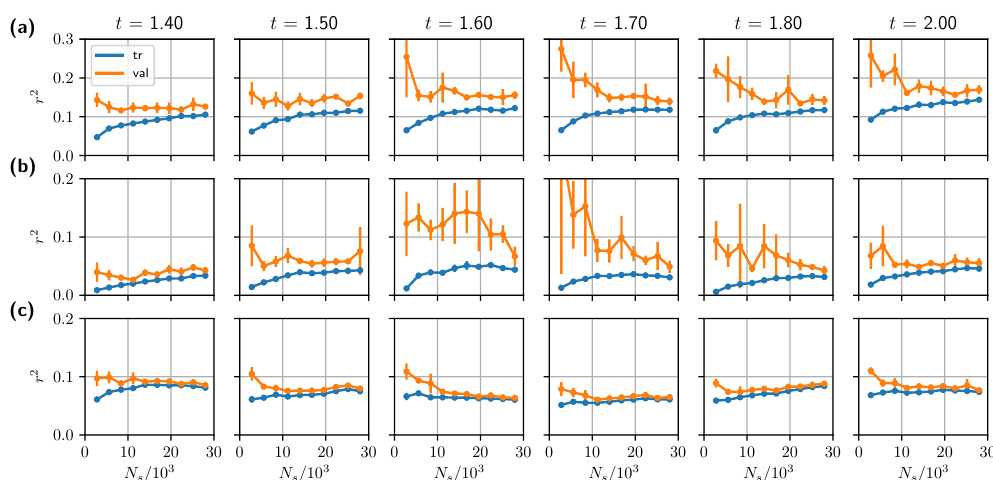
Figure 14: (a),(b) Comparison of TDVP and validation error for varying number of Monte Carlo samples on a linear scale for the same trajectory and parameters as in Fig. 10, with λ = 10 − 6 and at driving amplitudes A [ panel (b) ] in the 8 × 2 ladder system. (c) The same data for an A the 4 × 4 square geometry. In all panels, the error bars indicate the standard deviation over five independent realizations of the validation error as in Fig. 10.